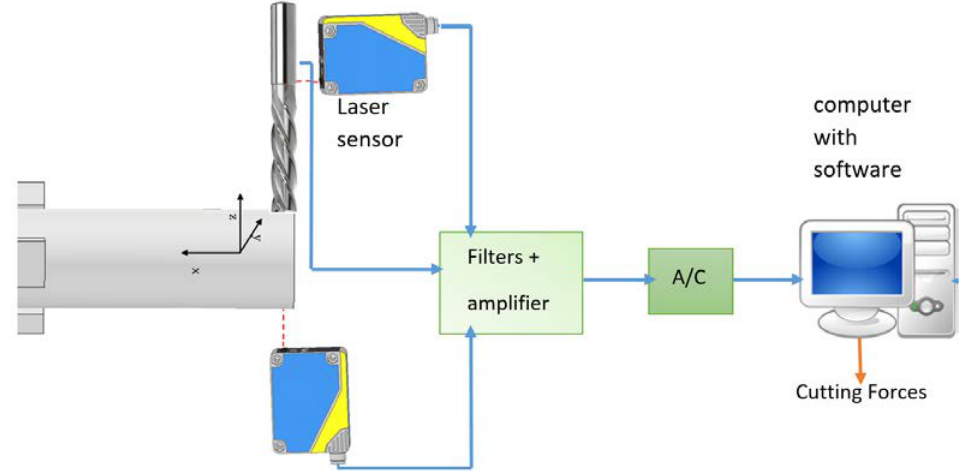
Figure 7. Scheme of determining cutting forces during turn-milling.